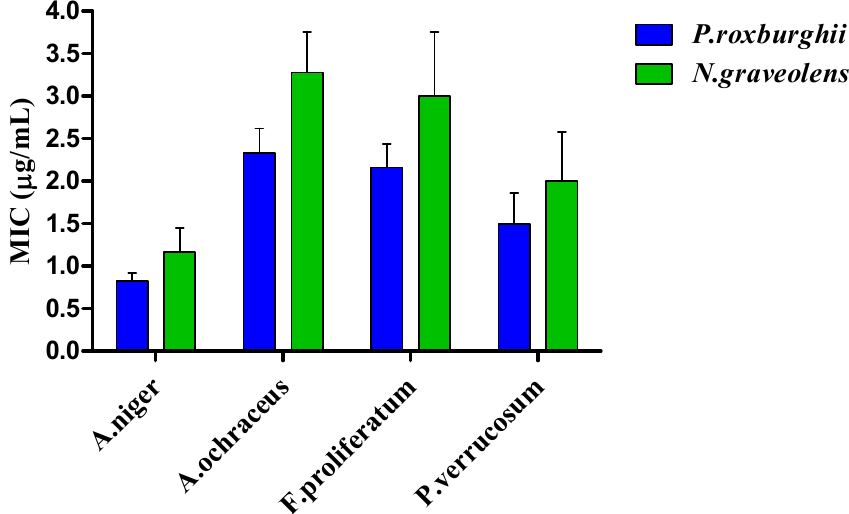
Figure 6. Minimum inhibitory concentrations of P. roxburghii and N. graveolens extracts against mycotoxigenic fungi.